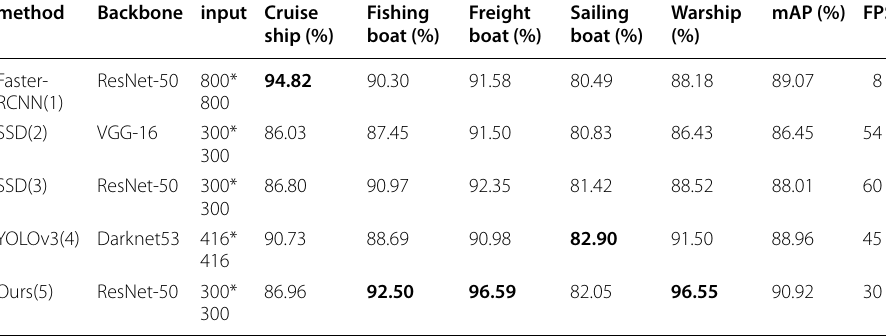
Bold indicates the largest value in the column and the asterisk stands for